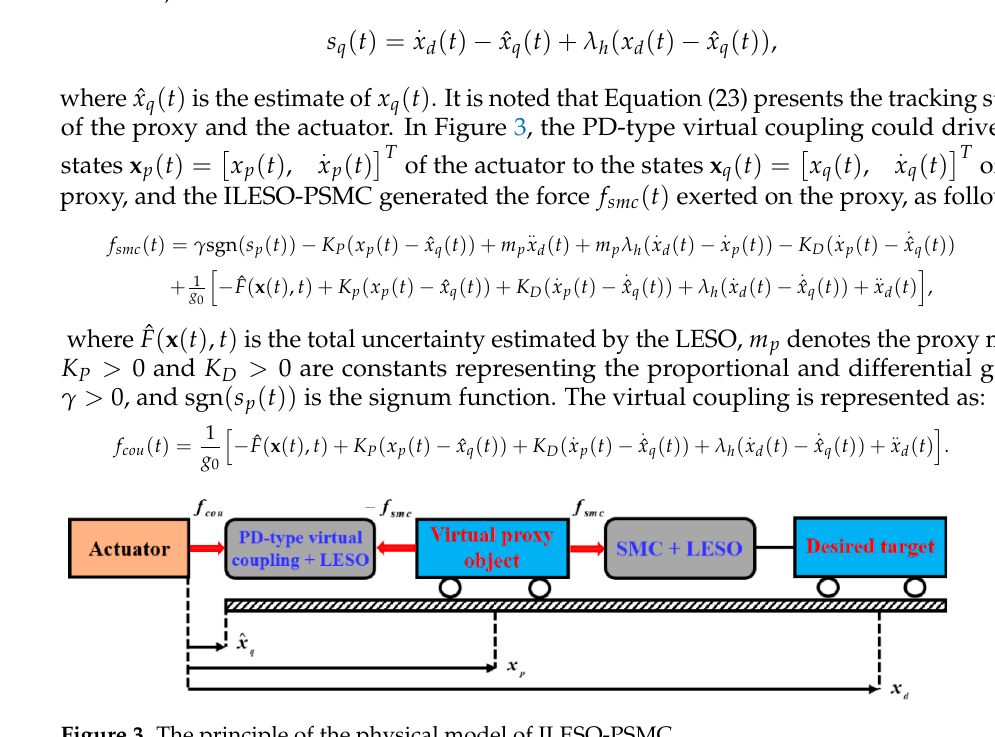
Figure 3. The principle of the physical model of ILESO-PSMC.